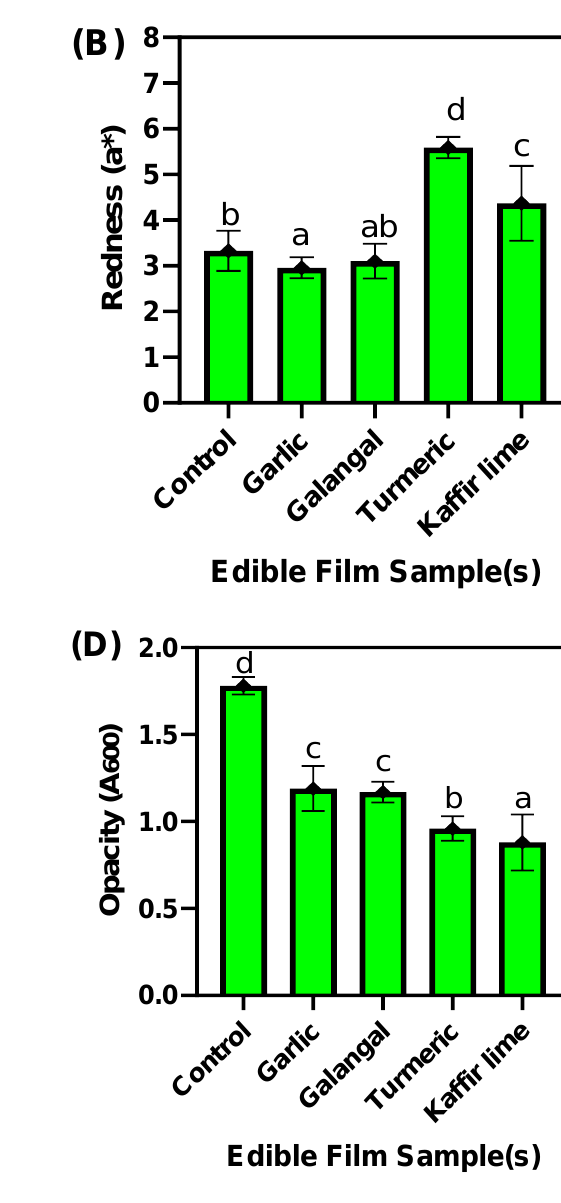
Figure 1. Color profile ( A – C ) and opacity ( D ) of chitosan–NGRS based edible films incorporated with and without EOs. Note: The different letters shown in the figure represents significant differences between means.